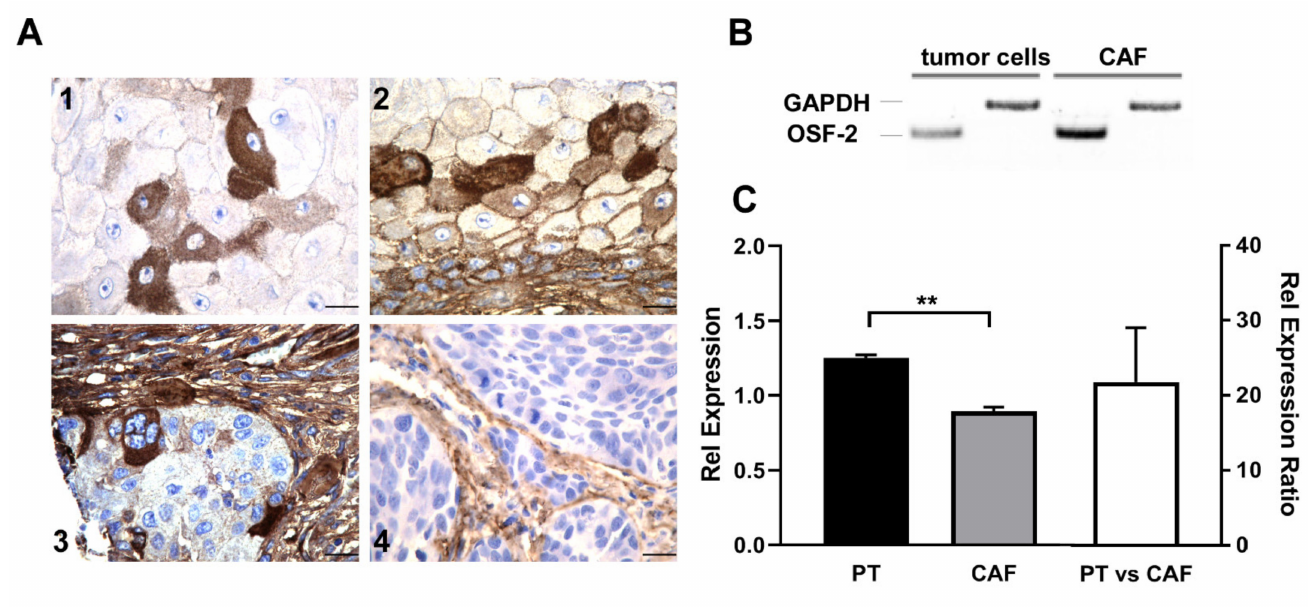
Figure 4. OSF-2 is expressed in the tumor microenvironment. ( A ) Immunohistochemical analysis of OSF-2 expression in primary HNC tissue. Intense staining was observed in cancer cells ( 1 , 2 ), but also in the juxtatumoral stroma ( 3 , 4 ). Scale bars, 20 µ m. ( B ) RT-PCR of primary tumor cells and CAFs revealed higher expression of OSF-2 in CAFs. GAPDH was used as a control. ( C ) Up-regulation of OSF-2 in CAFs compared to primary tumor cells was confirmed by quantitative real-time-PCR. Up-regulation is shown by lower C T values and thus, a lower relative expression for CAFs. OSF-2 expression in primary tumor cells (PT, black) and CAFs (grey) is shown compared to RNA-Pol II expression (OSF-2/RNA-Pol II; left axis), and as relative expression ratio R (right axis). R = 21.18, n = 2, ** p < 0.005. The uncropped western blot figures were presented in Figure